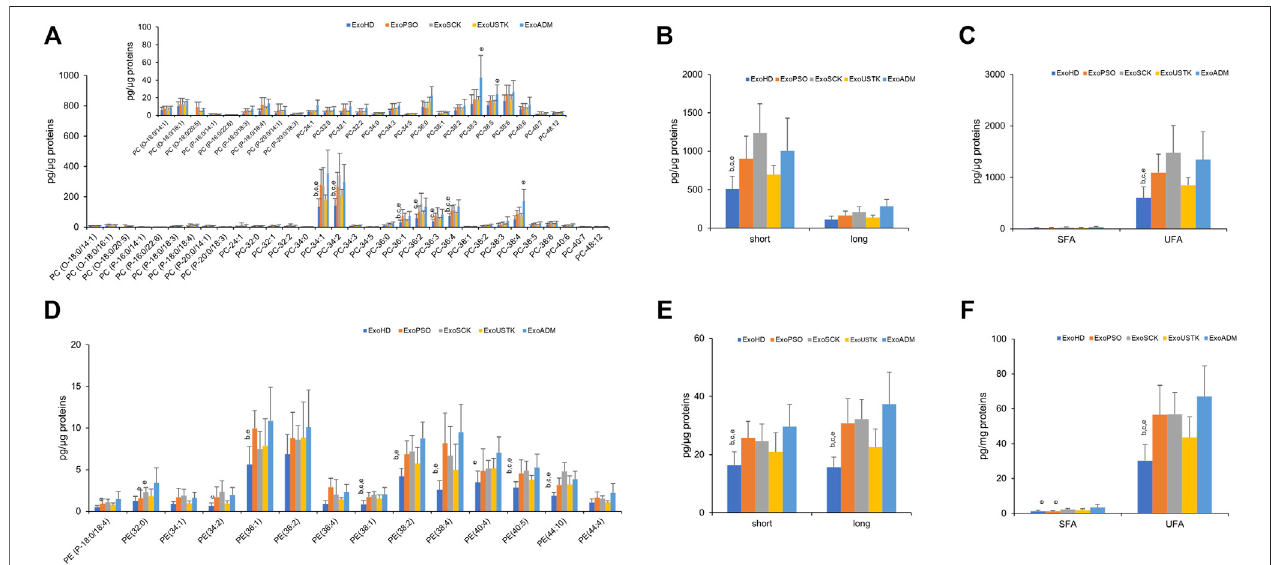
FIGURE 4 | Molecular species of PC and PE detected in Exo from plasma of HD, PSO and PSO treated with SCK, USTK and ADM. Lipid extracts from Exo were analyzedbyLC/MS – MS.Panels (A) and (D) showPCandPEdetectedspecies,respectively.Dataareexpressedaspgoflipidspecies/ μ gofproteins.Theinsertedpanel expand the vertical axis to allow comparison of low abundance lipid subclasses. Panels (B) and (E) show fatty acid length in PC and PE, respectively. Data are reported as sum of species containing short ( < 36 carbon atoms) and long chains ( > 38 carbon atoms). Panels (C) and (F) show saturation level of PC and PE, respectively. Data are reported as sum of molecular species containing only saturated (SFA) and unsaturated (UFA) fatty acids. Data are reported as mean ± SD; p < 0.05 was considered statistically signi fi cant by one-way ANOVA and Tukey ’ s post-hoc analysis; columns with different letters are signi fi cantly different (i.e. a vs. HD, b vs. PSO, c vs. SCK, d vs. USTK, e vs. ADM and π vs. all).